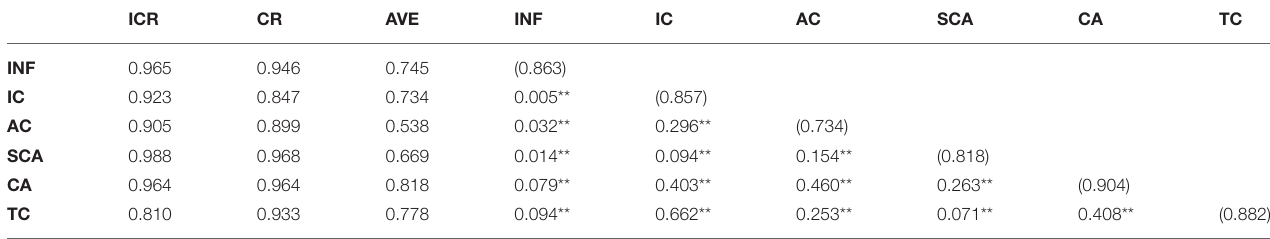
TABLE 2 | Correlation, reliability, and validity statistics.